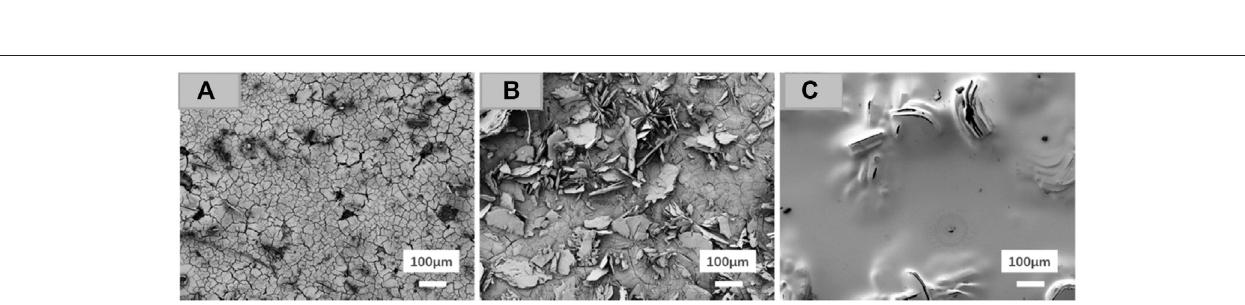
FIGURE 6 | Corrosion morphology with cross-sectional view (inset) after 1 week of immersion in SBF for different HA concentrations; (A) 500, (B) 1,000, and (C) 2,000 mg/L. Reproduced from (Nikbakht et al., 2021) with permission from the Royal Society of Chemistry.